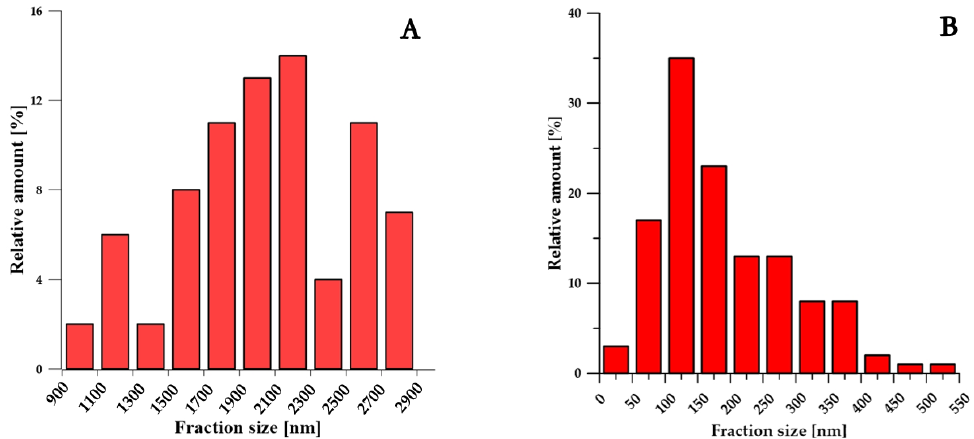
Figure 6 . Grain size distribution: ( A ) Zn, ( B) Zn – 1Mg – 0.5Sr.